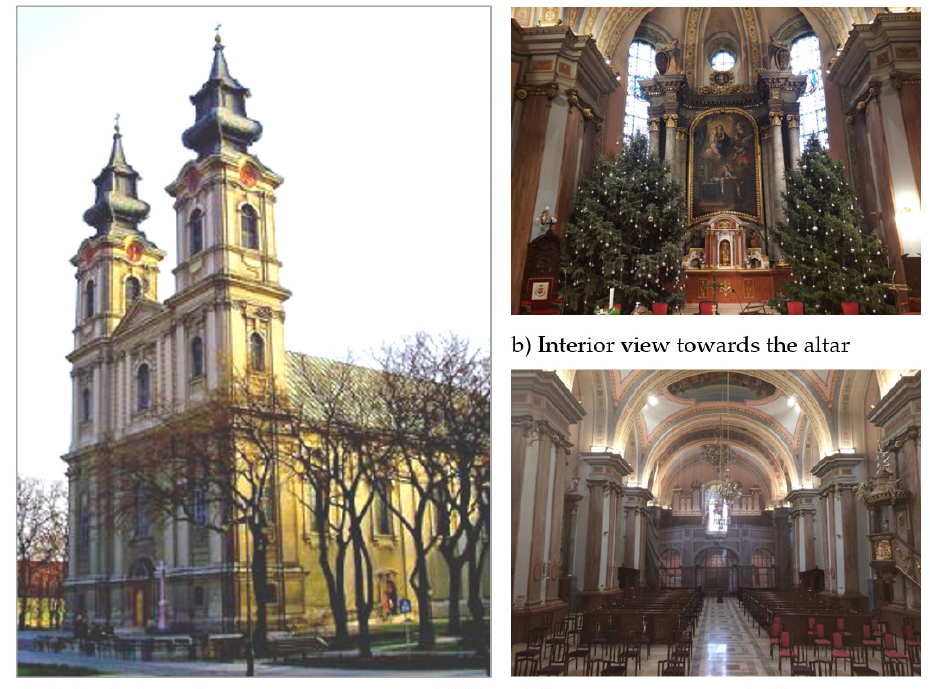
Figure 1. View of the north-eastern part of the Cathedral prior to 2017. ( a ) Cathedral, north-eastern view prior to 2017, ( b ) Interior view towards the altar, ( c ) Interior view towards the entrance.